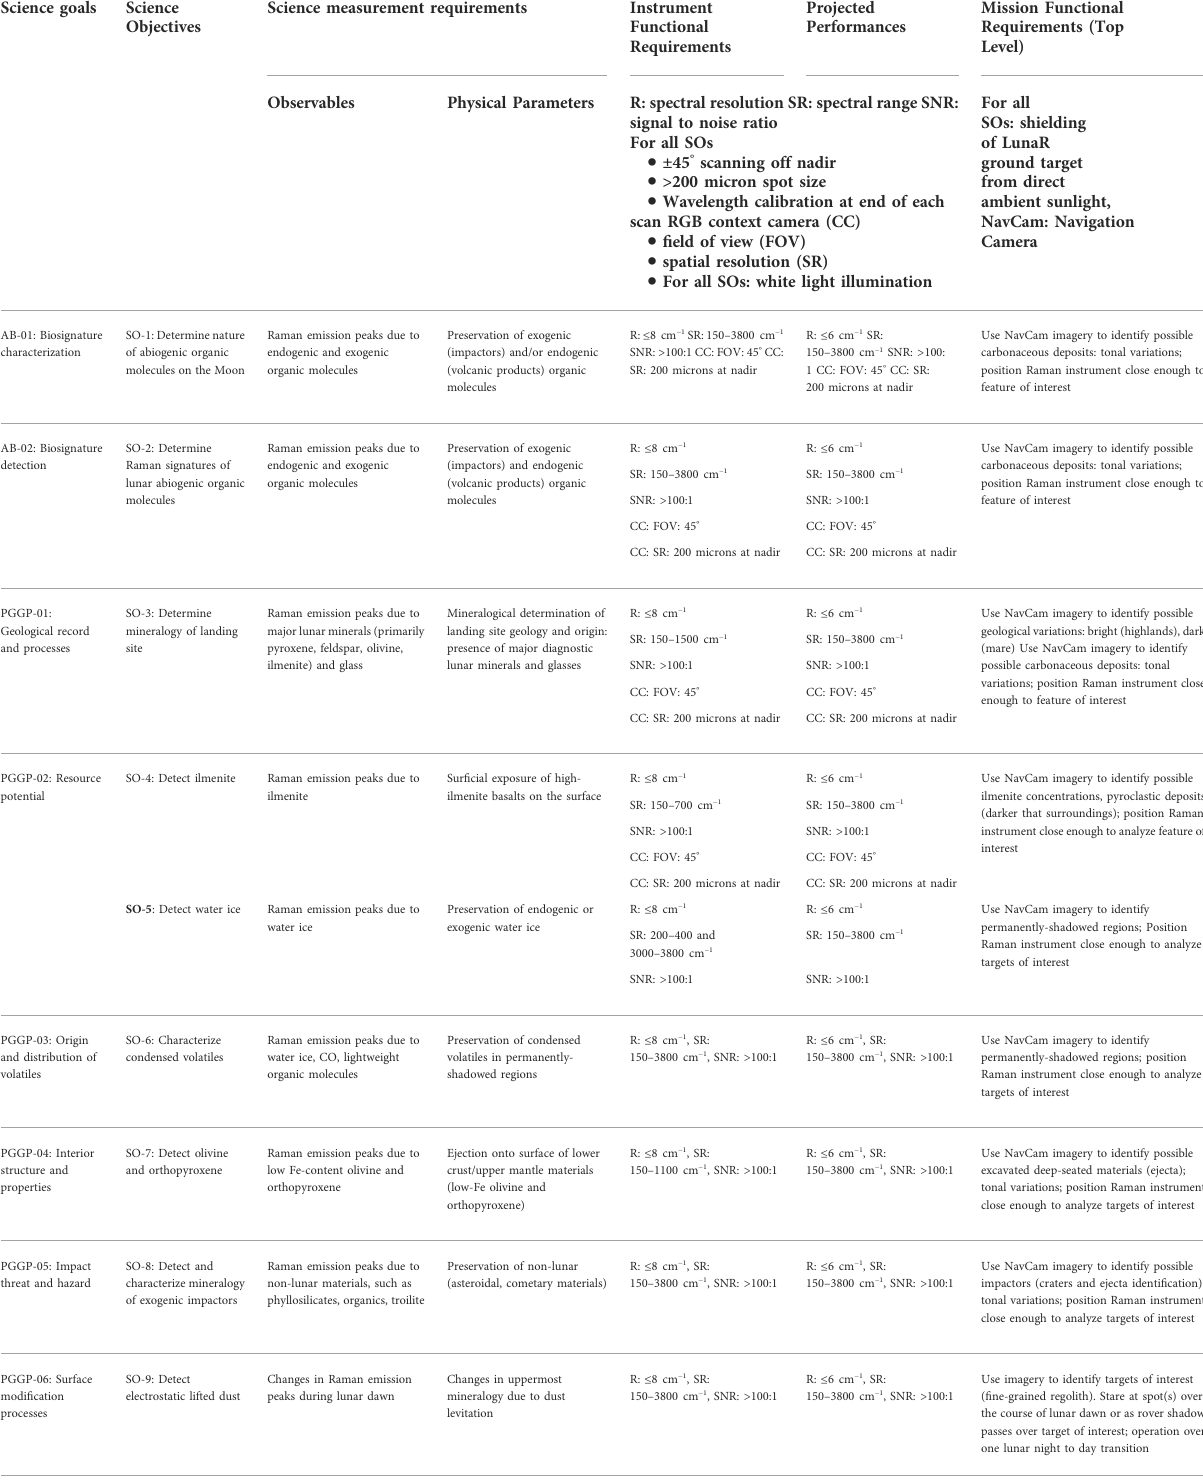
TABLE 1 LunaR Science Traceability Matrix (STM) presenting space community priorities and the mission goals. Science